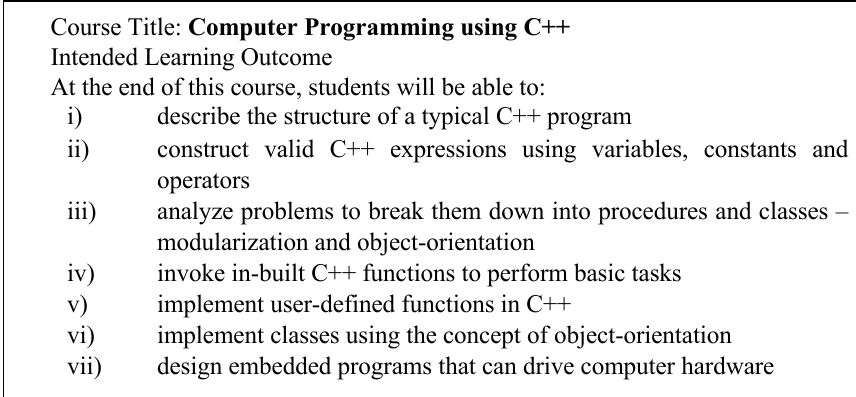
Fig. 7. A Sample of Learning Objective for Computer programming in